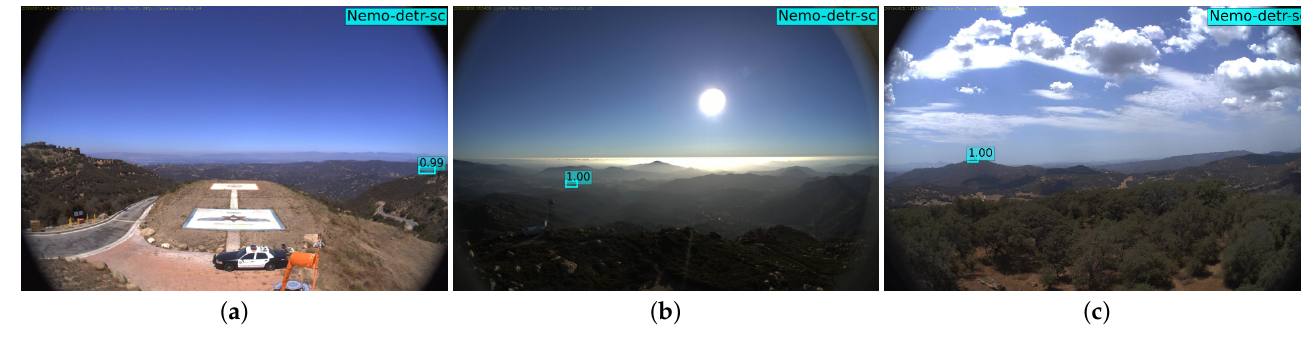
Figure 15. ( a ) 69bravo-n was taken on 13 August 2019 at 14:20. This image shows the correct detection of smoke at the time of ignition. ( b ) 20200806_SpringsFire_lp-w was taken on 6 August 2020 at 18:34, and ( c ) 20180809_FIRE_mg-w was taken on 9 August 2018 at 13:10. This image as well shows the correct zero-frame smoke